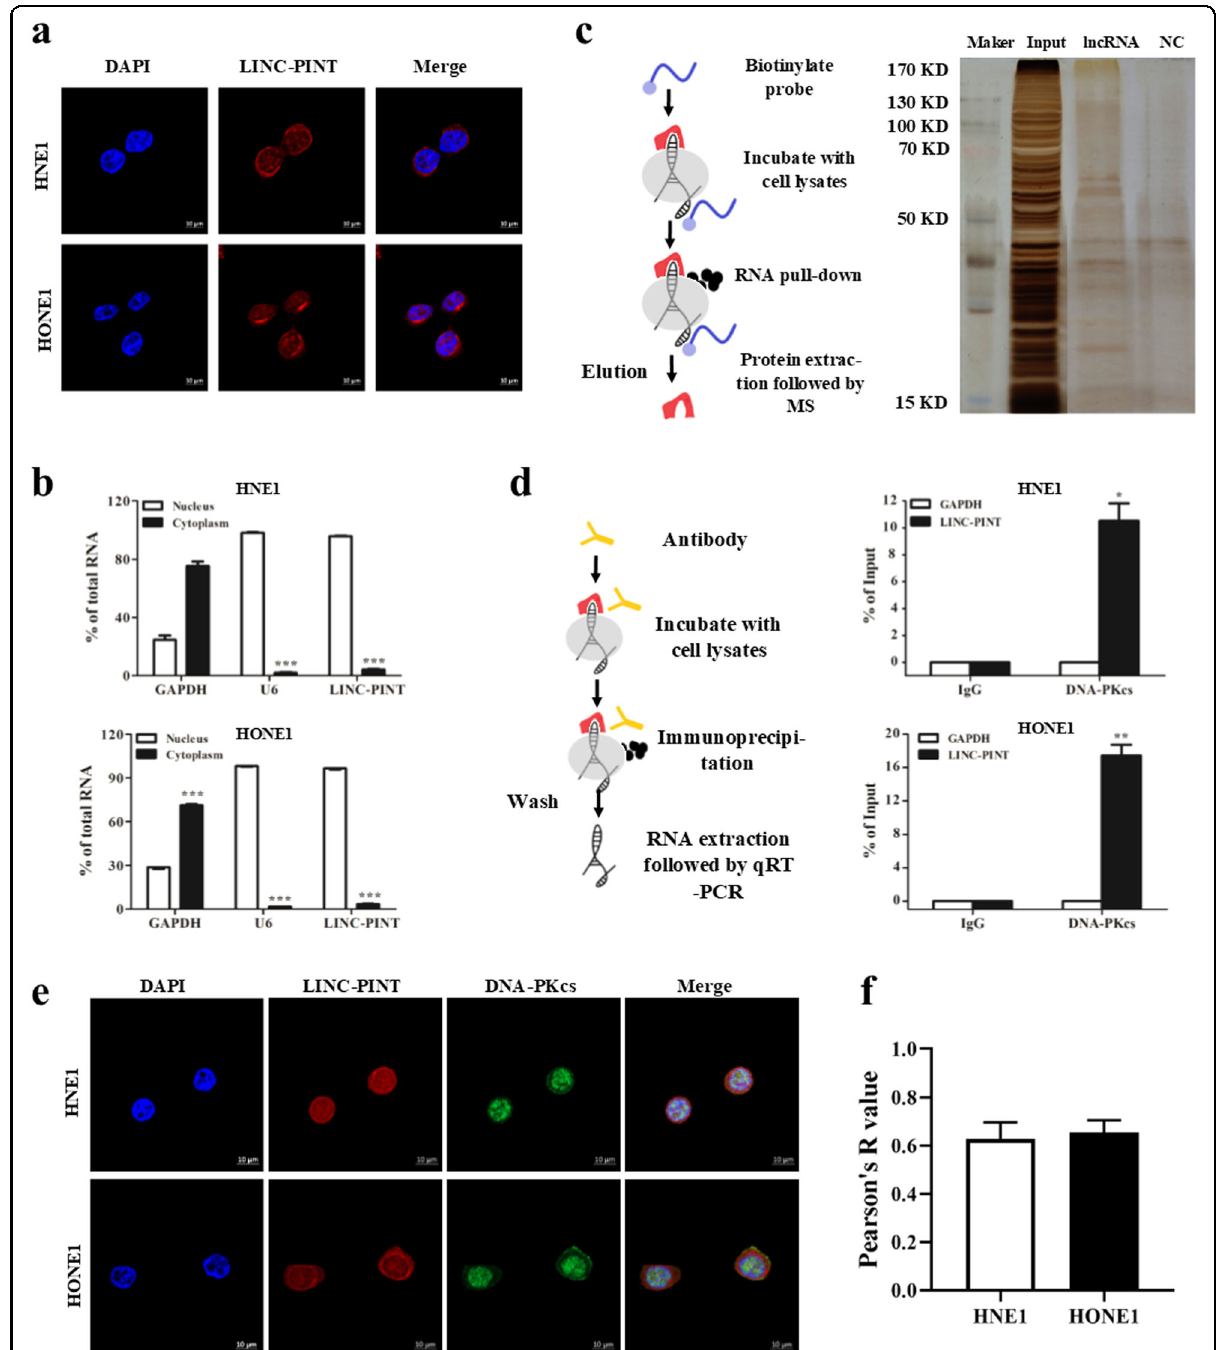
Fig. 5 DNA-PKcs is a direct target of LINC-PINT. a Representative images of the FISH assay for detecting the subcellular localization of LINC-PINT in HNE1 and HONE1 cell lines (scale bar, 10 μ m; blue, DAPI; red, LINC-PINT). b The expression of LINC-PINT in cytoplasmic and nuclear fractions of NPC cells. RNA samples were analyzed by qRT-PCR three times. Data represent the mean ± SEM. Statistical signi fi cance was calculated using a two-sided t test. * P < 0.05, ** P < 0.01, *** P < 0.001. c Identi fi cation of the binding proteins of LINC-PINT in HNE1 and HONE1 cells. Left, Schematic diagram of the RNA pull-down strategy. Right, results of Silver staining. d RIP was performed using anti-DNA-PKcs antibodies. Left, schematic diagram of the RIP assay. Right, the levels of LINC-PINT and GAPDH in the coprecipitates were determined by qRT-PCR. e , f Representative fl uorescence images ( e scale bars, 10 µm; blue, DAPI; r e d, LINC-PINT; green, DNA-PKcs) and quanti fi cation ( f n = 3 biologically independent samples) of colocalization between LINC-PINT and DNA-PKcs in HNE1 and HONE1 cells. Pearson ’ s R values were analyzed by Image